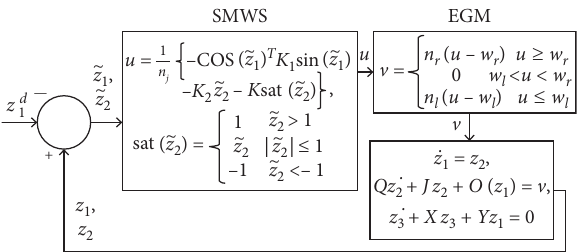
Figure 2: Sliding mode regulator with sine mapping.